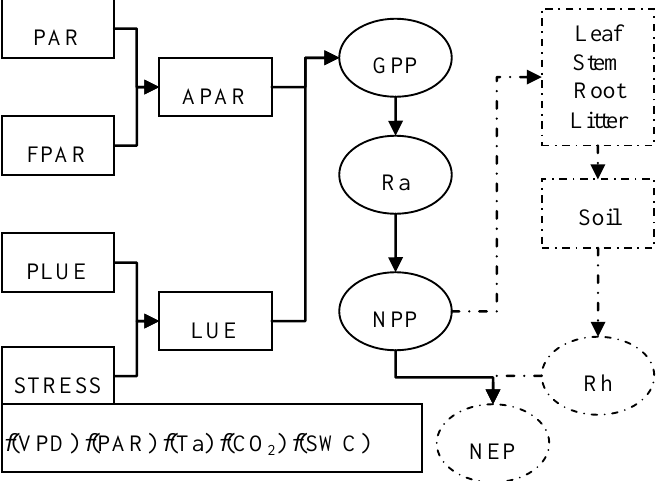
Figure 1. Framework of the GLOPEM-CEVSA model. GLOPEM-CEVSA represents the coupling of the GLObal Production Efficiency Model (GLO-PEM, shown by solid lines) with the Carbon Exchange between Vegetation, Soil and Atmosphere (CEVSA) model (shown by dashed lines). A detailed description of this model is available in